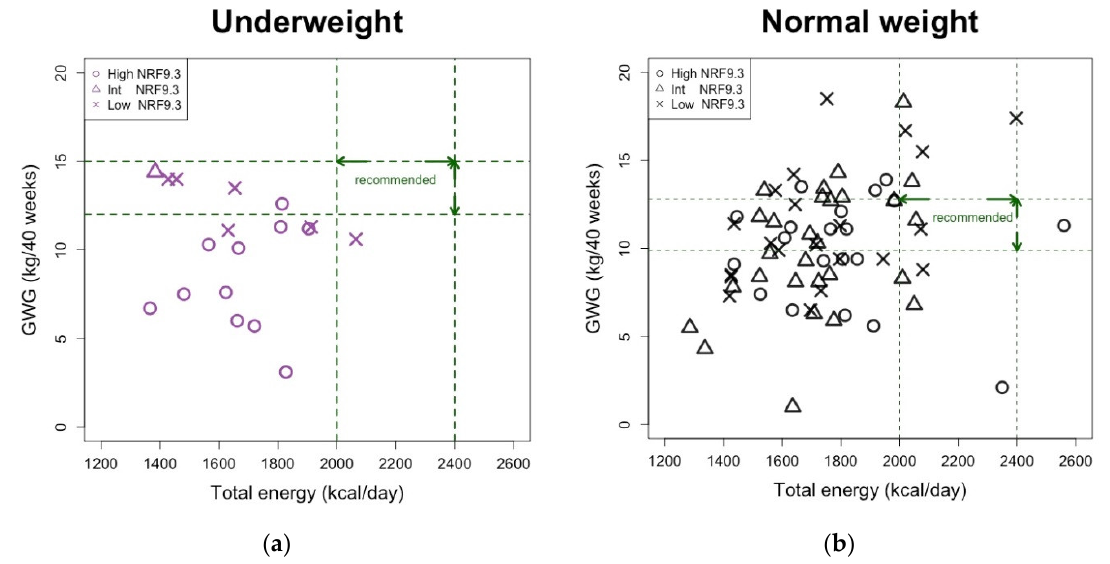
Figure 5. Relationship between energy intake and GWG, with presentation of the individual’s diet quality status in ( a ) underweight and ( b ) normal weight women. Each subject (( a ), n = 18; ( b ), n = 69) is shown in a scatter plot. Open circles, open triangles, and cross indicate high, intermediate, and low NRF9.3 scores, respectively. Green dashed lines indicate the recommended range.